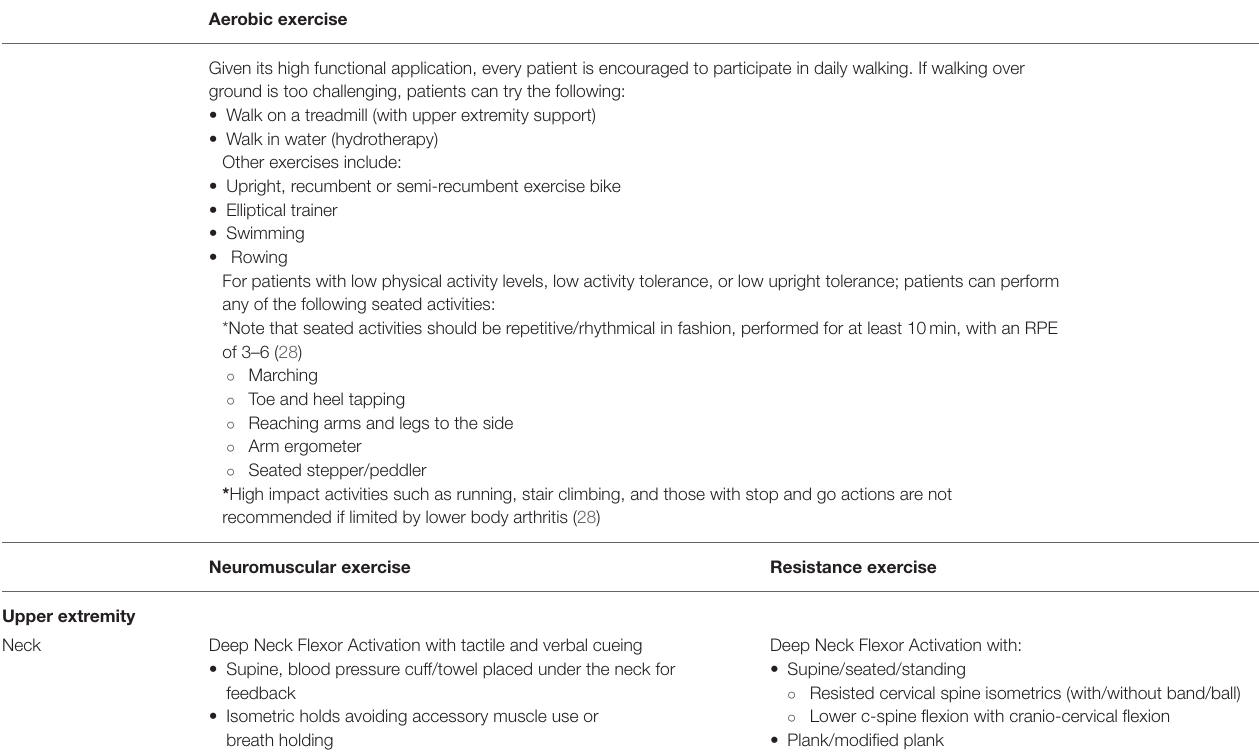
TABLE 2 | Sample of GEAR’s exercise and rehabilitation exercises. Aerobic